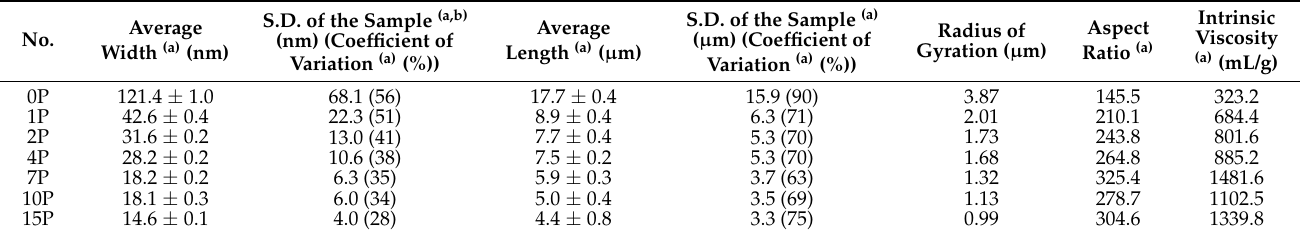
Table 1. Morphological characteristics and intrinsic viscosity of CNF dispersions (adapted from Albornoz-Palma et al.